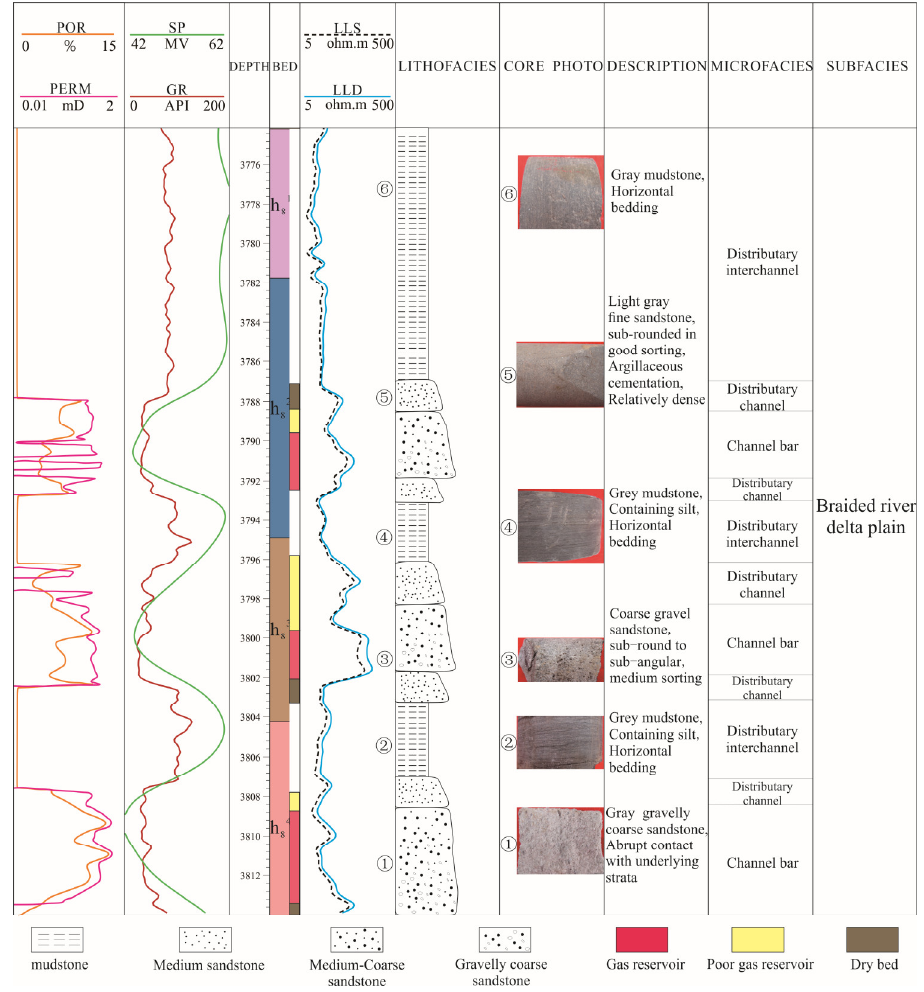
Figure 2. Comprehensive histogram of well X in Ct3 study area in P 2 h 8 member.